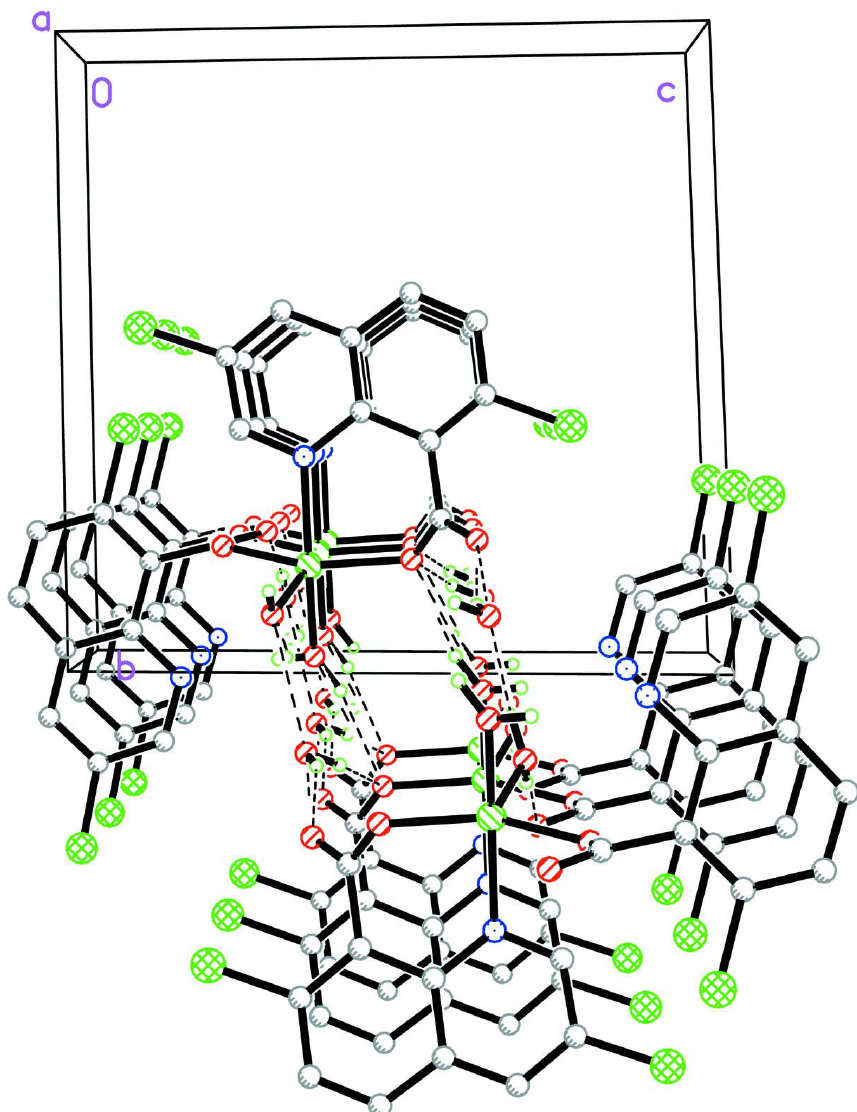
Part of the crystal structure of (I), showing the 1-D helical chain.H atoms bonded to C atoms have been omitted for